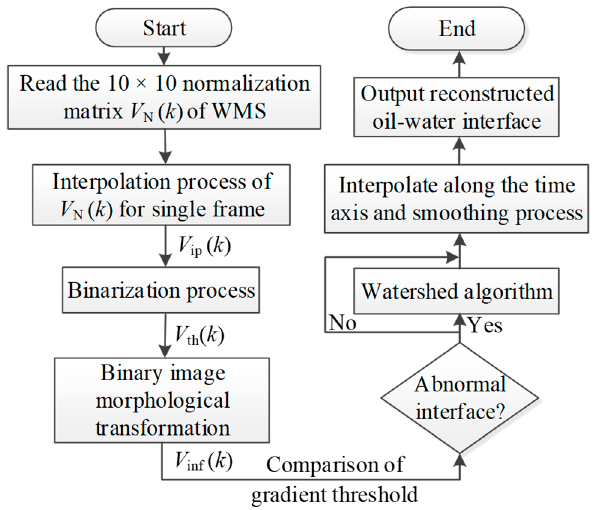
Figure 15. Flow chart for the extraction of the oil–water interface.